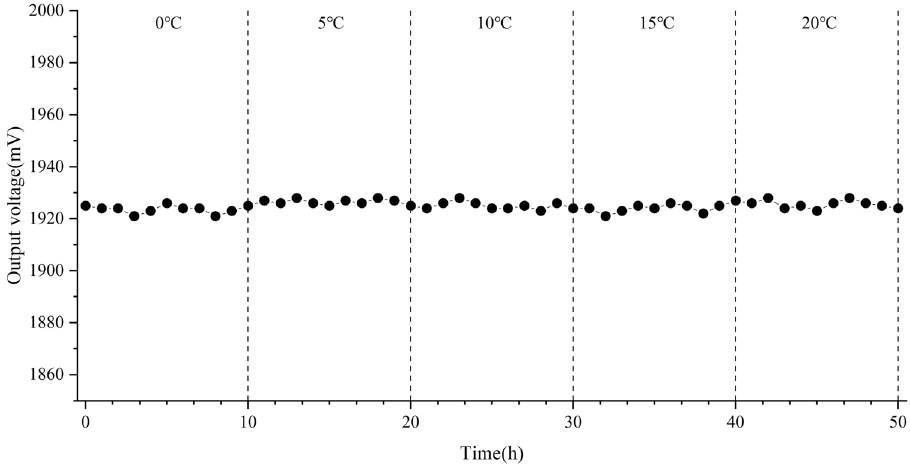
Figure 14. Sensor output voltage curve in different temperature ranges (The figure was generated by Origin 2016 × 64 (https:// www. origi nlab. com/ 2016)).